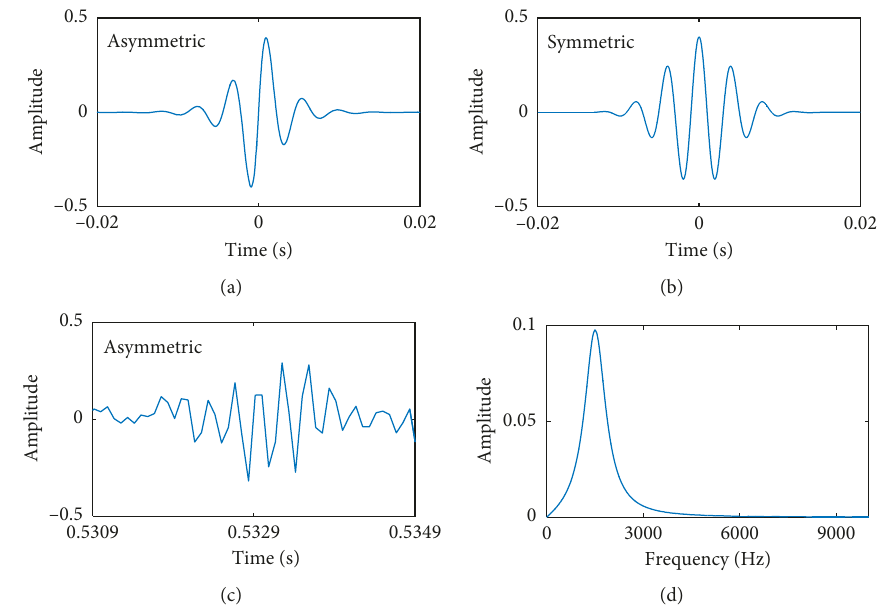
Figure 1: The TW of (a) ARLW; (b) Morlet wavelet; (c) fault impact; (d) FS of